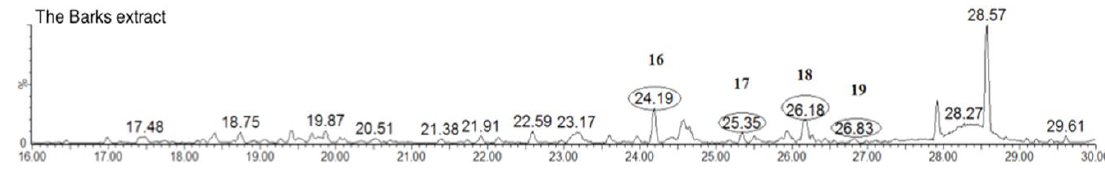
Figure 8. Typical total ion chromatogram of triterpenoids of the MRB